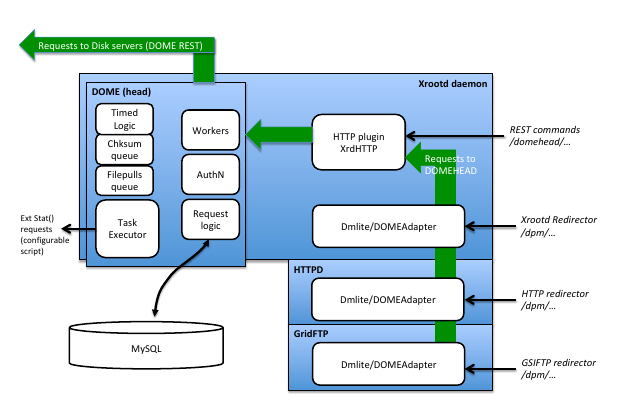
Figure 2. Simplified diagram of DOME in a head